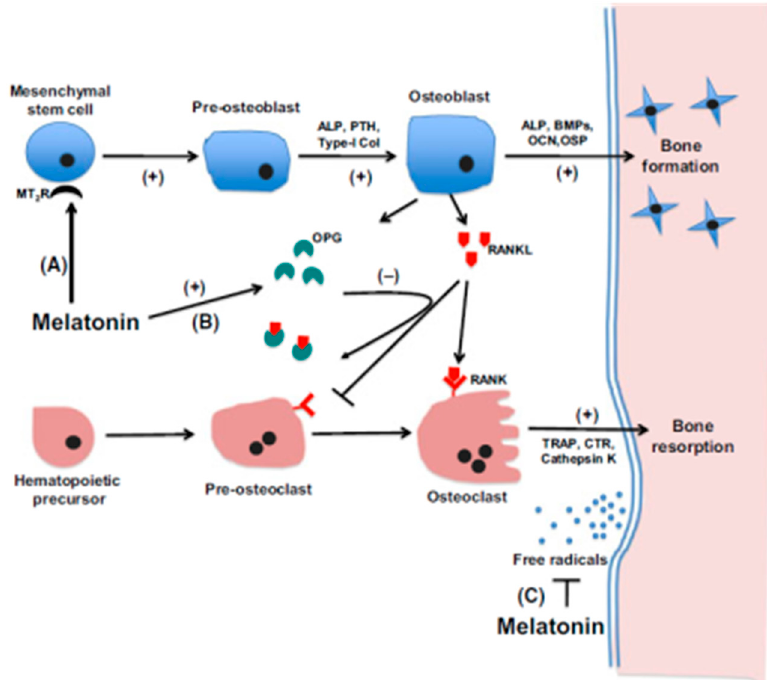
Figure 4. The proposed mechanisms underlying melatonin’s actions on bone formation. ( A ) melatonin The proposed mechanisms underlying melatonin’s actions on bone formation. induces MSCs differentiation into osteoblasts via MT2; ( B ) it promotes osteoprotegerin (OPG) expression ( A ) melatonin induces MSCs differentiation into osteoblasts via MT2; ( B ) it promotes in preosteoblasts which would inactive RANKL, leading to a suppression of osteoclastogenesis; and ( C ) through melatonin’s free-radical scavenging and antioxidant properties, protecting against radical induced loss of osteoblasts and osteoclasts. PTH (parathyroid hormone); Type I col (type I collagen); OSP (osteopontin); BMP-2 (bone morphogenetic protein 2); ALP (alkaline phosphatase); OCN (osteocalcin); TRAP (tartrate-resistant acid phosphatase); RANKL (receptor activator of NF ĸ B ligand); OPG (osteoprotegerin). From Maria and Witt-Enderby [262].